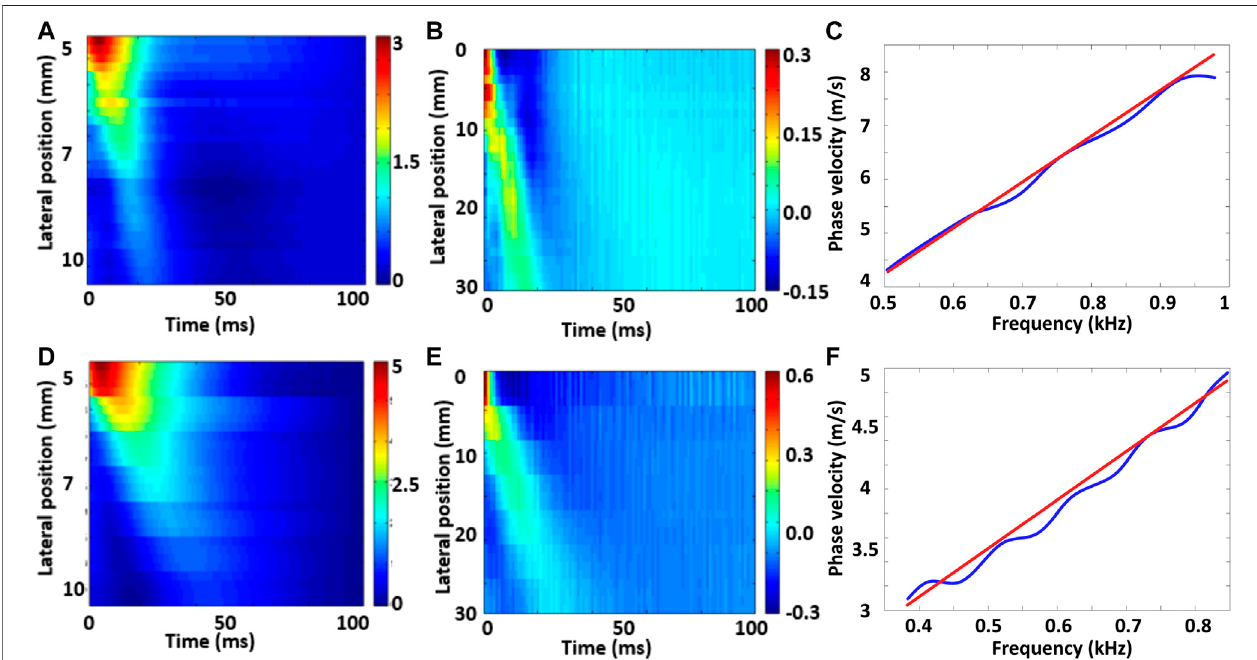
FIGURE 9 | Particle displacements (A and D) , particle velocities (B and E) and dispersion curves (C and F) for the fi ltered data in the early (A – C) and late (D – F) week of gestation in the longitudinal study. In the dispersion curves, the blue line is the value of the phase velocity measured at the maximum power at each temporal frequency, and the red line is the linear fi